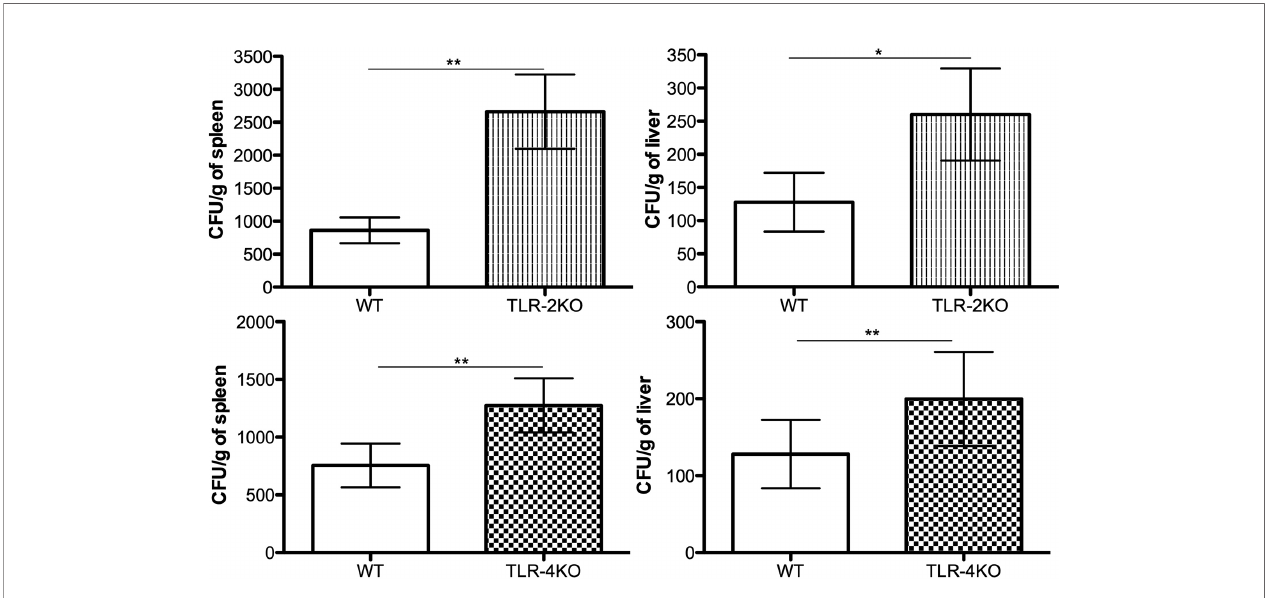
FIGURE 6 | TLR-2 and TLR-4 are essential for fungal load control in early F. pedrosoi conidia infection. WT, TLR-2KO, and TLR-4KO animals were infected i.p. with 5x10 7 F. pedrosoi conidia. After 24 h, the animals were euthanized, and the liver and spleen were harvested. An aliquot was seeded onto Sabouraud agar to fungal load analysis. Data are expressed as mean ± SEM; n = 10, Student t. * p <0.05; ** p